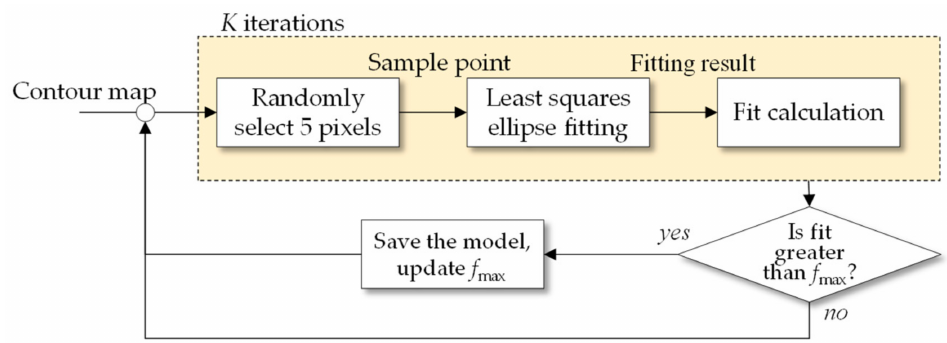
Figure 5. Flow chart of the iterative least squares ellipse fitting